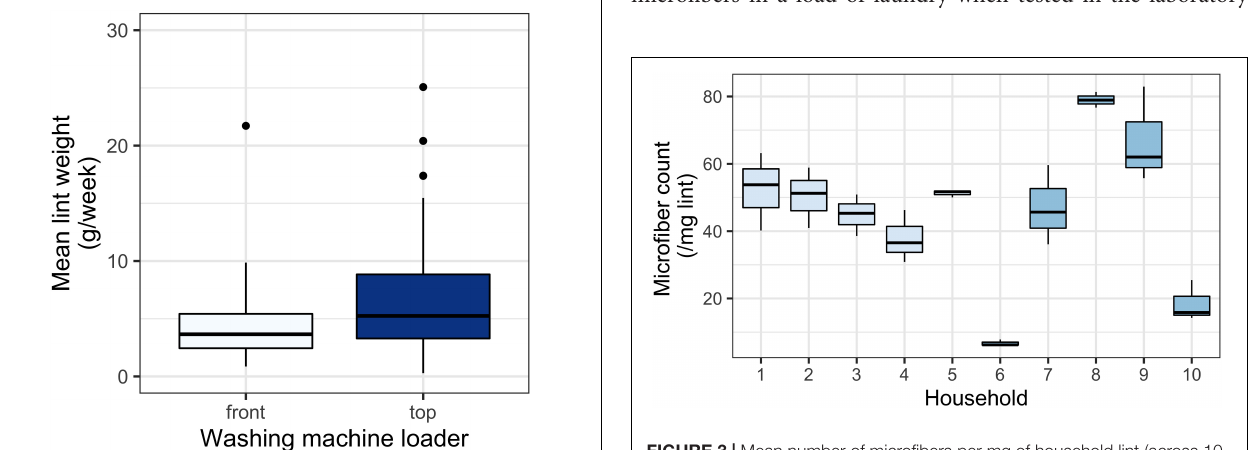
Frontiers in Marine Science |